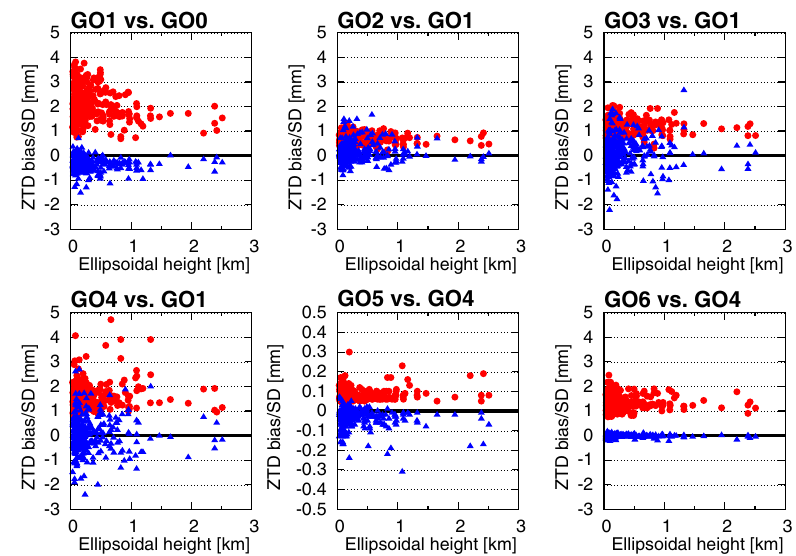
Figure 13. Dependence of ZTD biases (blue) and standard deviations (red) from inter-comparisons of the GOP second reprocessing solution variants on station ellipsoidal height. Note the different y range for the GO5 vs. GO4